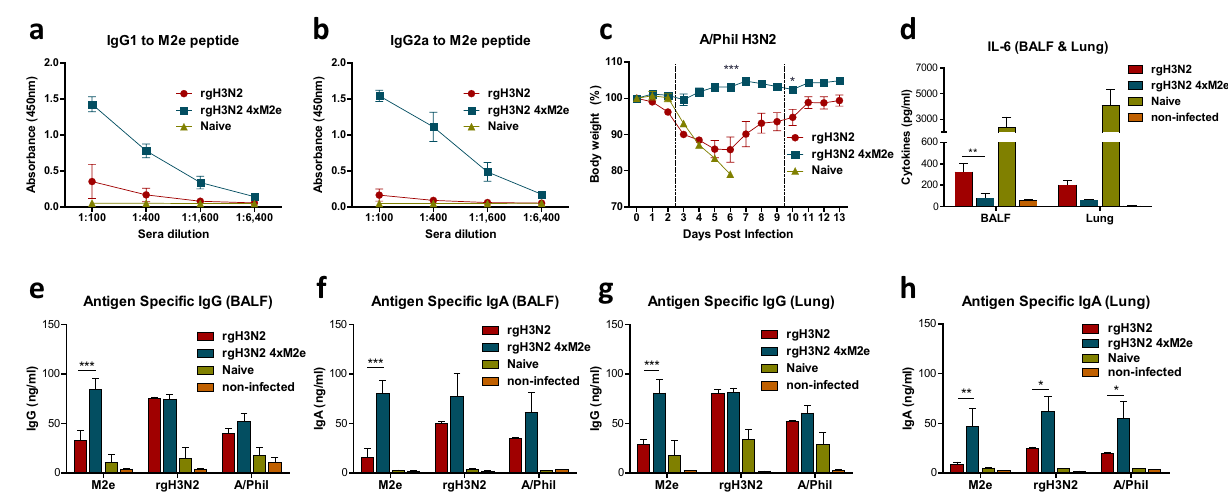
Figure 7. Boost dose of rgH3N2 4xM2e enhances cross protection against A/Phil (H3N2) challenge, correlating with M2e specific IgG levels and lower inflammatory cytokine. Sera were collected at 2 weeks after boost immunization of primed mice with rgH3N2 or rgH3N2 4xM2e. ( a ) IgG1 or ( b ) IgG2a antibody responses to M2e peptide. The rgH3N2 or rgH3N2 4xM2e boosted mice (n = 4 /group) were treated with α-CD4/α-CD8 (10 µg/10 µg per individual) antibodies for T cell depletion prior to A/Phil (H3N2) challenge. ( c ) Weight changes of rgH3N2 or rgH3N2 4xM2e prime-boost mice after challenge with A/Phil (200 LD 50 ). ( d ) IL-6 levels in BALF or lung extracts at day 5 post challenge with A/Phil. ELISA of IgG or IgA antibodies specific for M2e peptide and inactivated virus antigens (rgH3N2 or A/Phil) in ( e , f ) BALF and ( g , h ) lung extracts at day 5 post challenge with A/Phil. Error bars indicate mean ± SEM. The statistical significances between rgH3N2 group versus rgH3N2 4xM2e group were determined using two-way ANOVA and indicated in *, P < 0.05; **, P < 0.01; ***, P <